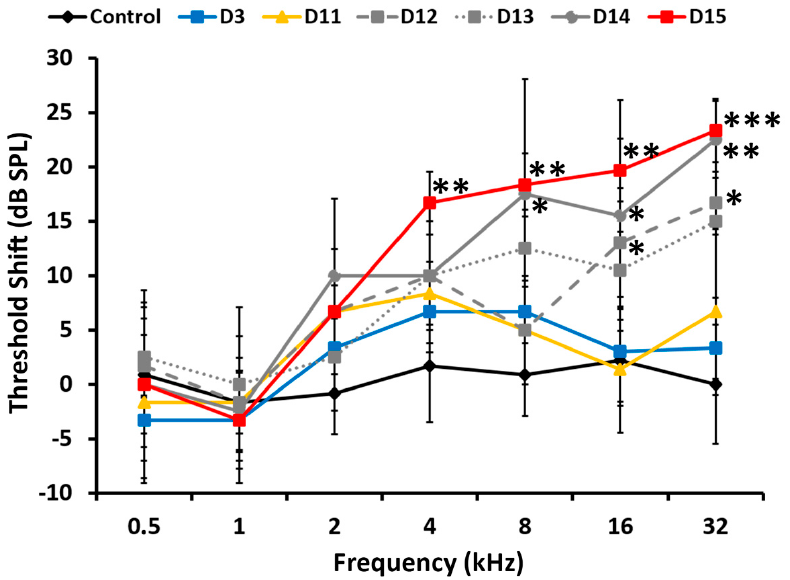
Figure 1. Threshold shift progression in rats treated daily with subcutaneous kanamycin (400 mg/kg/day) for up to 15 days. The progression of threshold shifts is shown at days 3 (D3), 11 (D11), 12 (D12), 13 (D13), 14 (D14) and 15 (D15) after the initiation of treatment. Values are expressed as mean ± SD. Significant threshold shifts are first recorded at D12 at 16 kHz and above. At D14, elevated thresholds affect frequencies down to 8 kHz, and by D15 there are elevated thresholds down to 4 KHz. * p < 0.05, ** p < 0.005, *** p < 0.001 vs. control group treated with vehicle.